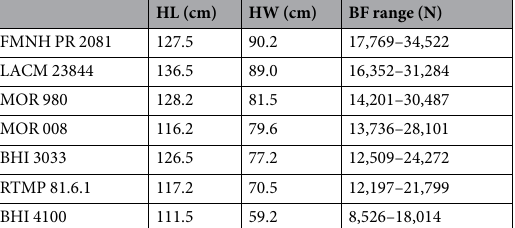
Table 1. Adult 52 Tyrannosaurus rex specimens, head lengths (HL), head widths (HW), and bite forces (BF, in newtons [N]) estimated in this study (see Methods and Supplementary Table S2 for measurement details and forces at specific tooth positions; see main text for museum